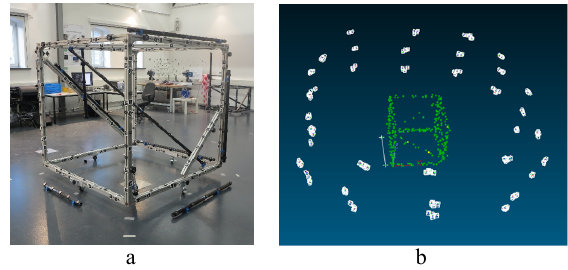
Figure 4. VDI test volume (a) and imaging setup (b). A bundle adjustment for each dataset results in an RMS of object point precision in each axis of about 20 µm. This corresponds to the expected quality level of the used camera setup. Three calibrated lengths along the coordinate axes are applied as scale